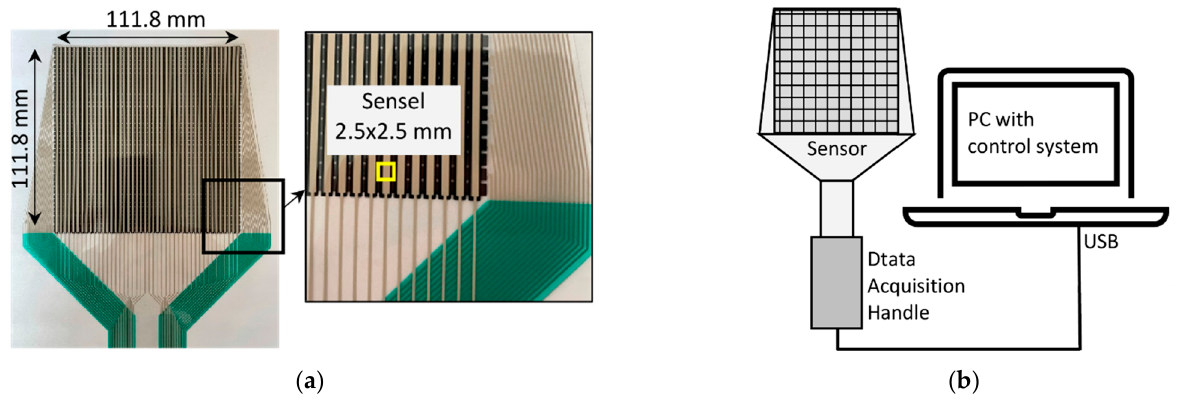
Figure 3. ( a ) Photo of the tactile sensor with a zoom on one sensel. ( b ) Scheme of the measuring system .